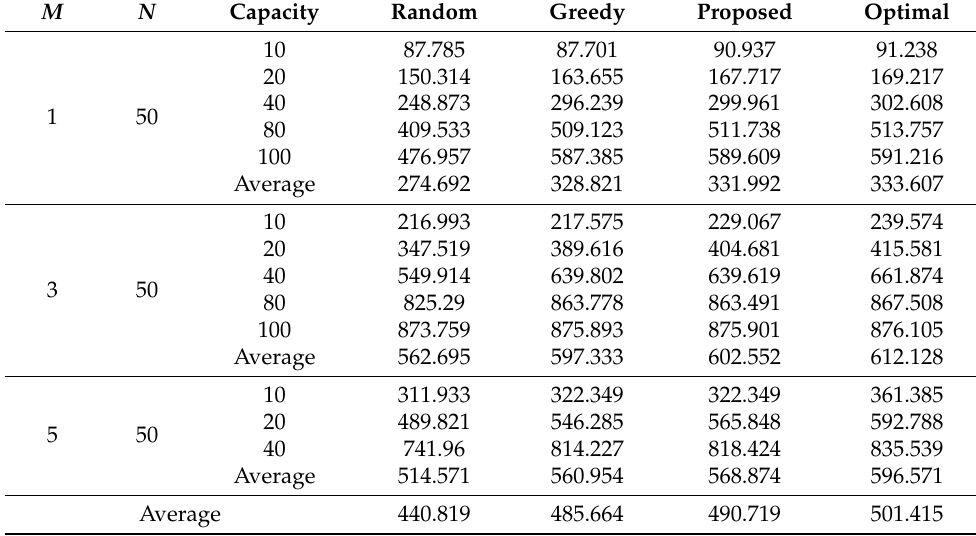
Table 9. Profit of selected items in QI set.